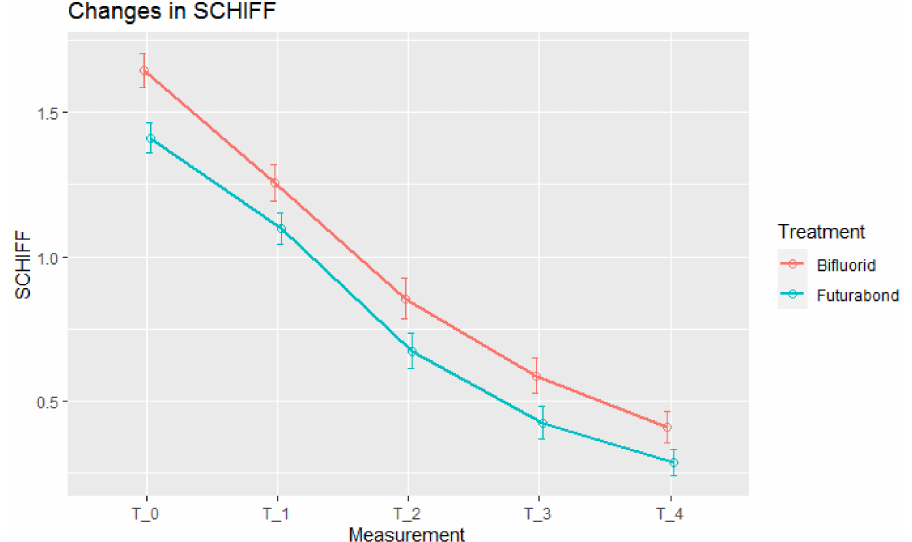
Figure 1. Pain intensity, Schiff measurements. Means ± std. errors.